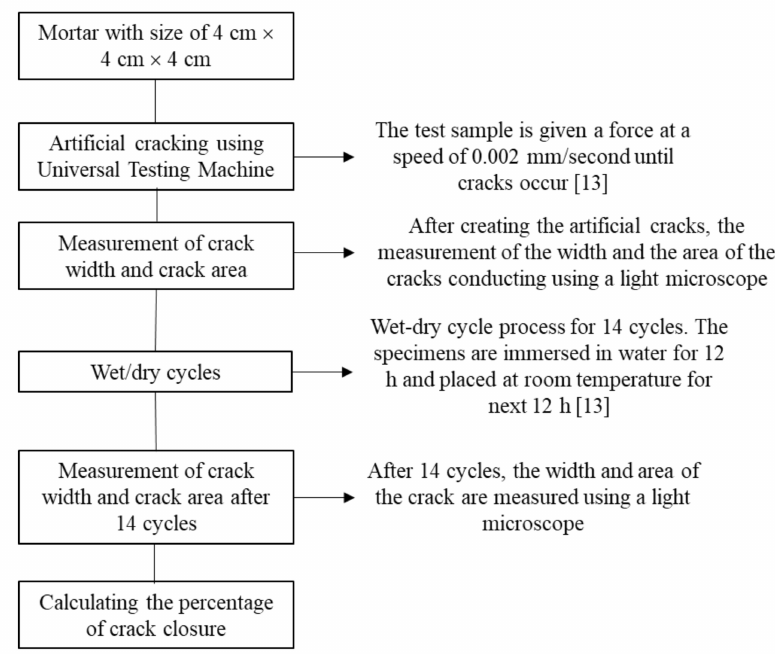
Figure 4. Self-healing testing process.